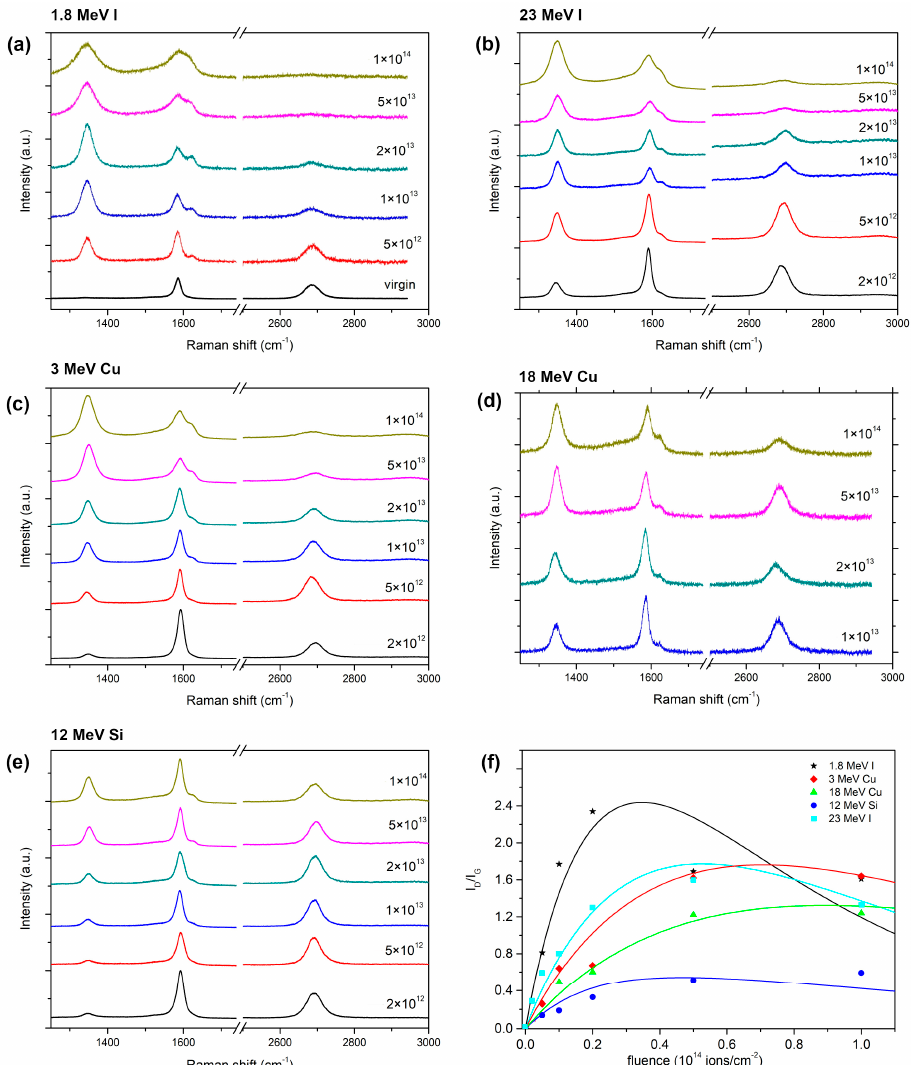
Figure 2. Raman spectra (532 nm excitation wavelength) of TLG samples irradiated with ( a ) 1.8 MeV I, ( b ) 23 MeV I, ( c ) 3 MeV Cu, ( d ) 18 MeV Cu, and ( e ) 12 MeV Si. Ion fluences (depicted by different colours and given in ions/cm 2 units) are given above each spectrum. ( f ) Ratio I D / I G for all used ion beams fitted using the Lucchese model (Equation (1)).